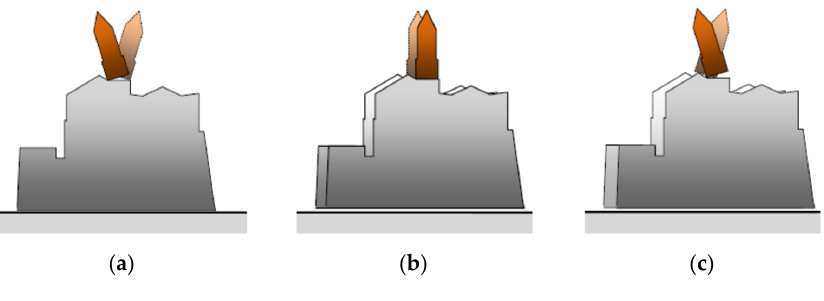
11 of 18 Figure 8. G round and fl oor spectra at the base of bell tower. The dynamic analysis was developed taking into account a double-block system in which the bell tower, due to the large friction coe ffi cient between itself and the remaining building, had the only rocking motion, while the only sliding motion of the lower struc- ture was considered according to Equation (20). The possible analysed motions are (see schematic representation in Figure 9):